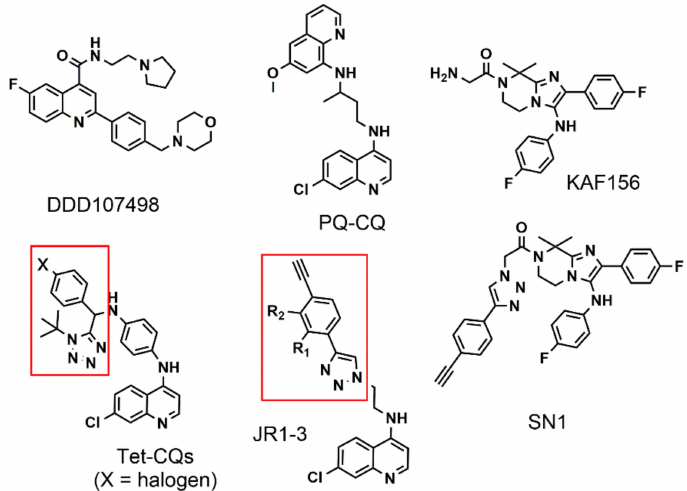
Figure 1. Molecular structures of antimalarial drugs mentioned in the introduction. JR1-3 and SN1 are the molecules designed for this study (vide infra for details). The red box indicates the structural feature that we took as reference for the design of the